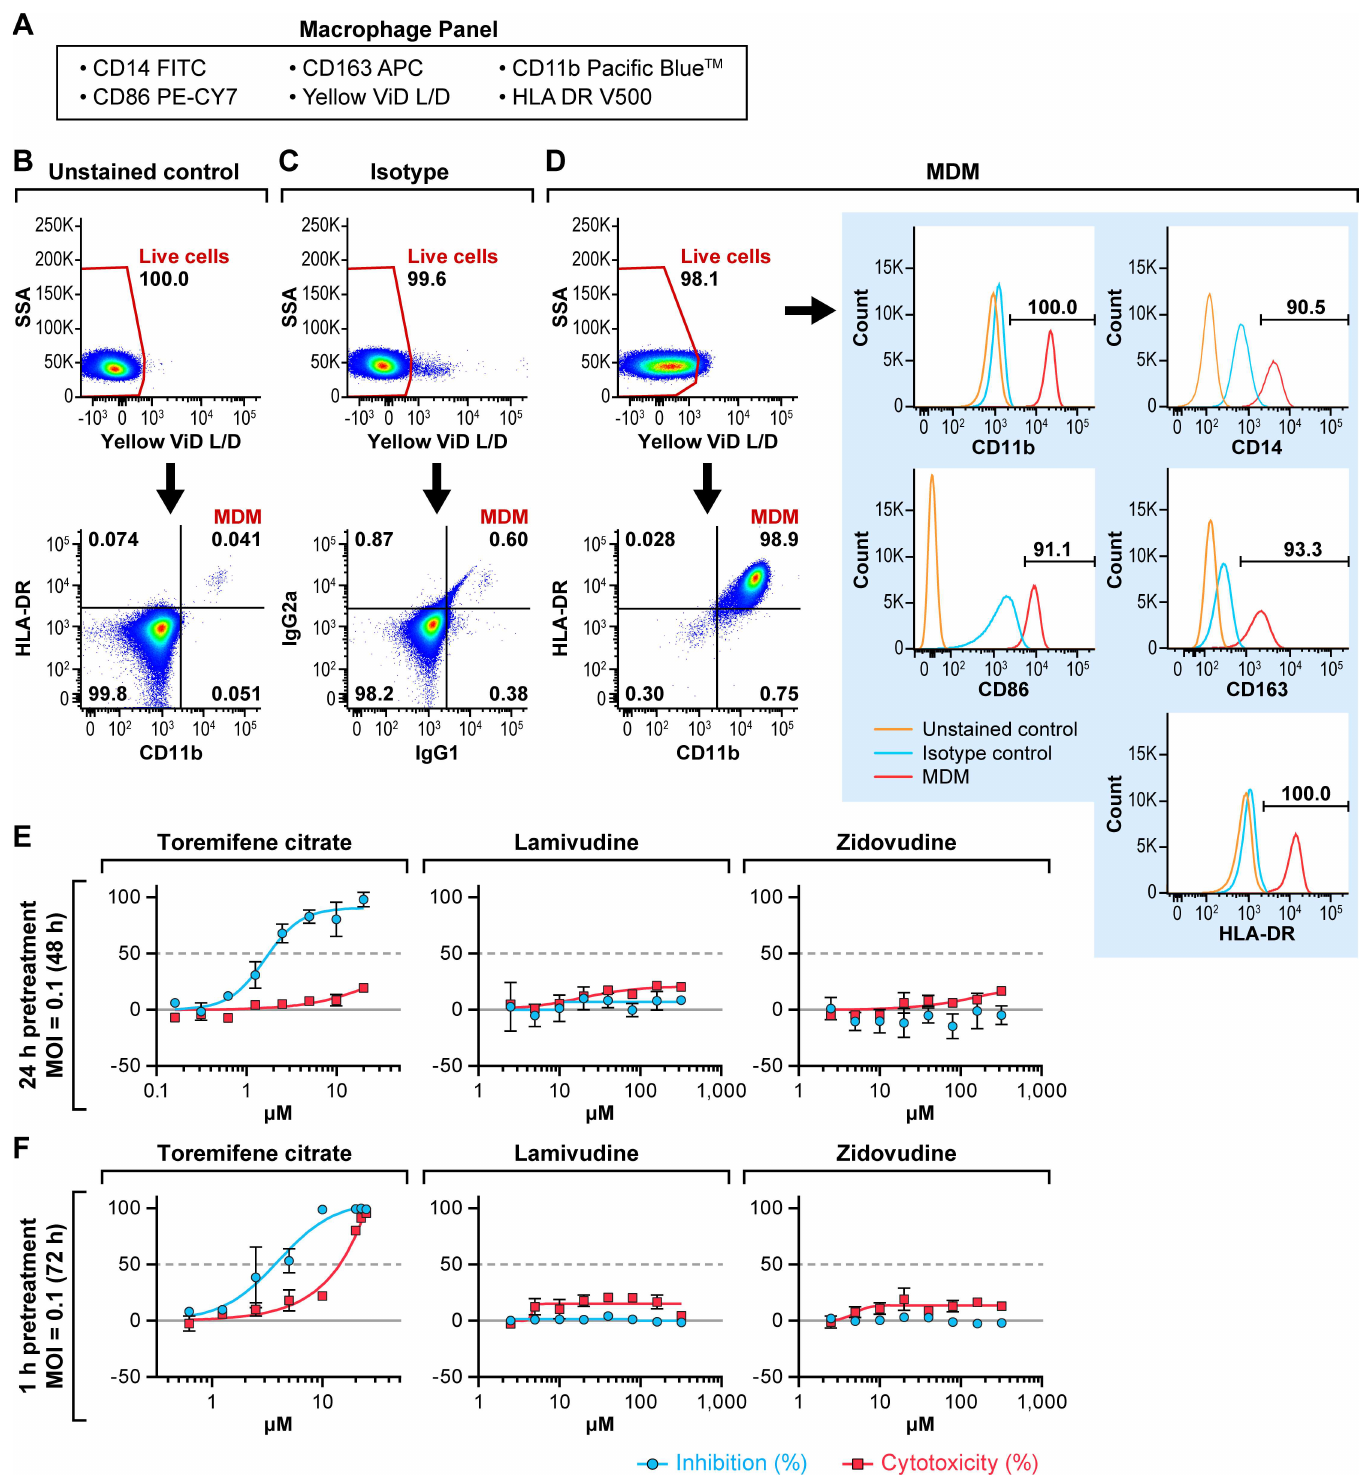
Fig 3. Antiviral activity of lamivudine and zidovudine against EBOV/Mak in MDMs. (A) MDMs were surface stainedwith the macrophage panel markers listed. (B) The unstainedcontrol sample was stained with LIVE/DEAD FixableYellow Dead Cell Stain (Yellow ViD L/D) only. (C, D) The MDM populationwas measuredaccordingto double-positive CD11b and HLA-DRgating. The expressionof individualmacrophage markers (red line) were gated basedon the isotype control (blue line). The percentageof cells positive for each marker is indicated( > 90%). (E, F) MDMs were treated with toremifene citrate,